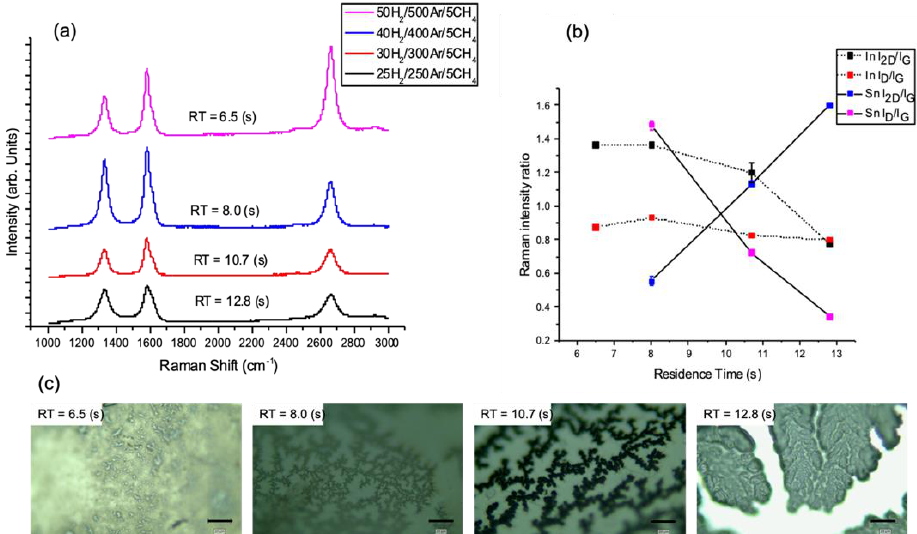
Figure 1. ( a ) Raman spectra of the APCVD graphene on liquid In using different reactants residence times, ( b ) Average Raman intensity ratios of I 2D /I G and I D /I G of the grown graphene on liquid In (dotted dash lines) and on liquid Sn from previous study [10] (doted solid lines) with respect to residence time (error bars are smaller than some of the data points). ( c ) Optical images of the as-grown graphene films (the dark areas) (scale bar: 20 µ m), some blurriness is due to the surface curvature of the solidified In (APCVD, T = 1120 C, (25–50) H 2 /(250–500) Ar/5 CH 4 sccm, t = 5 min).